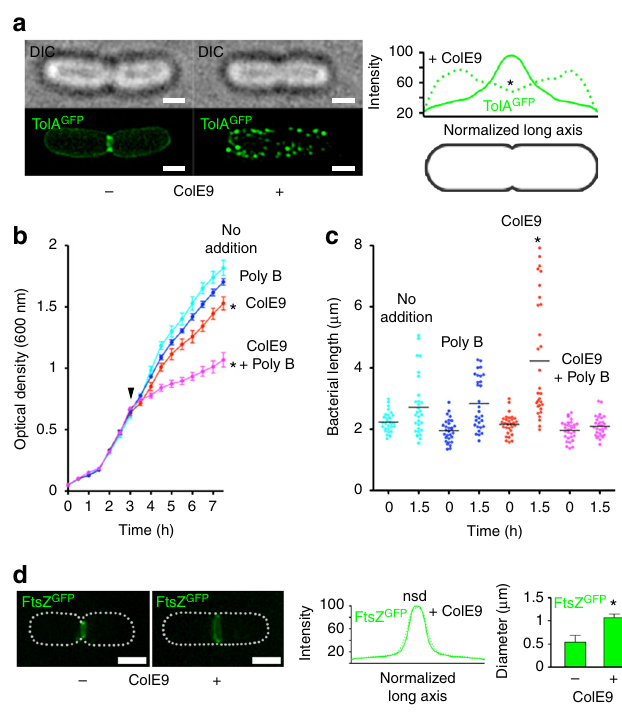
Fig. 4 OMP-bound ColE9 sequesters TolA away from the cell division apparatus and destabilises the OM. a Representative DIC and 3D-SIM images of dividing E . coli JW0729/pNP4, pRP5 cells expressing GFP-TolA (not induced) and BtuB (induced), respectively, in the absence ( − ) and presence ( + ) of ColE9, respectively. The differential distribution of GFP- TolA across cells, displayed graphically on the right-hand side, shows how formation of the colicin-mediated transenvelope bridge pushes TolA towards the poles and diminishes recruitment to the divisome. Asterisk, p < 0.001 from a Mann – Witney U -test from 30 cells. b Growth curves for JW0729/pNP4, pRP5 cells expressing GFP-TolA (not induced) and BtuB (induced), respectively, in the absence or presence of polymyxin B (144 nM), ColE9 or a mixture of polymyxin B and ColE9. Results shown are for M9 minimal media but the same results were obtained for rich media (Methods). Cells are able to grow at the concentration of polymyxin B used in these experiments unless ColE9 is included, which indicates that the transenvelope bridge formed by the colicin increases the permeability of the OM. Asterisk, p < 0.01 from a Student ’ s t test. c Distribution of cell length for JW0729/pNP4, pRP5 cells expressing GFP-TolA (not induced) and BtuB (induced), respectively, imaged by differential interference contrast (DIC) microscopy at the beginning of the growth experiment (0 h) and after growth (1.5 h) on agar pads, in the absence or presence of polymyxin B, ColE9 and a ColE9/polymyxin B mixture. ColE9-induced capture of TolA results in signi fi cant elongation of cells. Asterisk, p < 0.001 from a Mann – Witney U -test. d Representative 3D-SIM images of FtsZ-GFP and BtuB expressing E . coli PB199/pRP5 cells grown in agar pads in the absence ( − ) and presence ( + ), respectively, of ColE9 and imaged at the same time point (45 min). Normalised fl uorescence distributions show that the location of the Z -ring is unaltered, but the diameter of the ring increases signi fi cantly suggesting ring closure is delayed and explains the cell elongation phenotype in c . Scale bars, 1 μ m